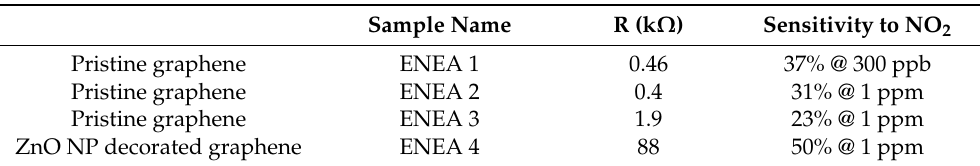
Table 10. Summary of the basic resistance values of the sensors produced by ENEA and the corre- sponding sensitivity towards NO 2 .